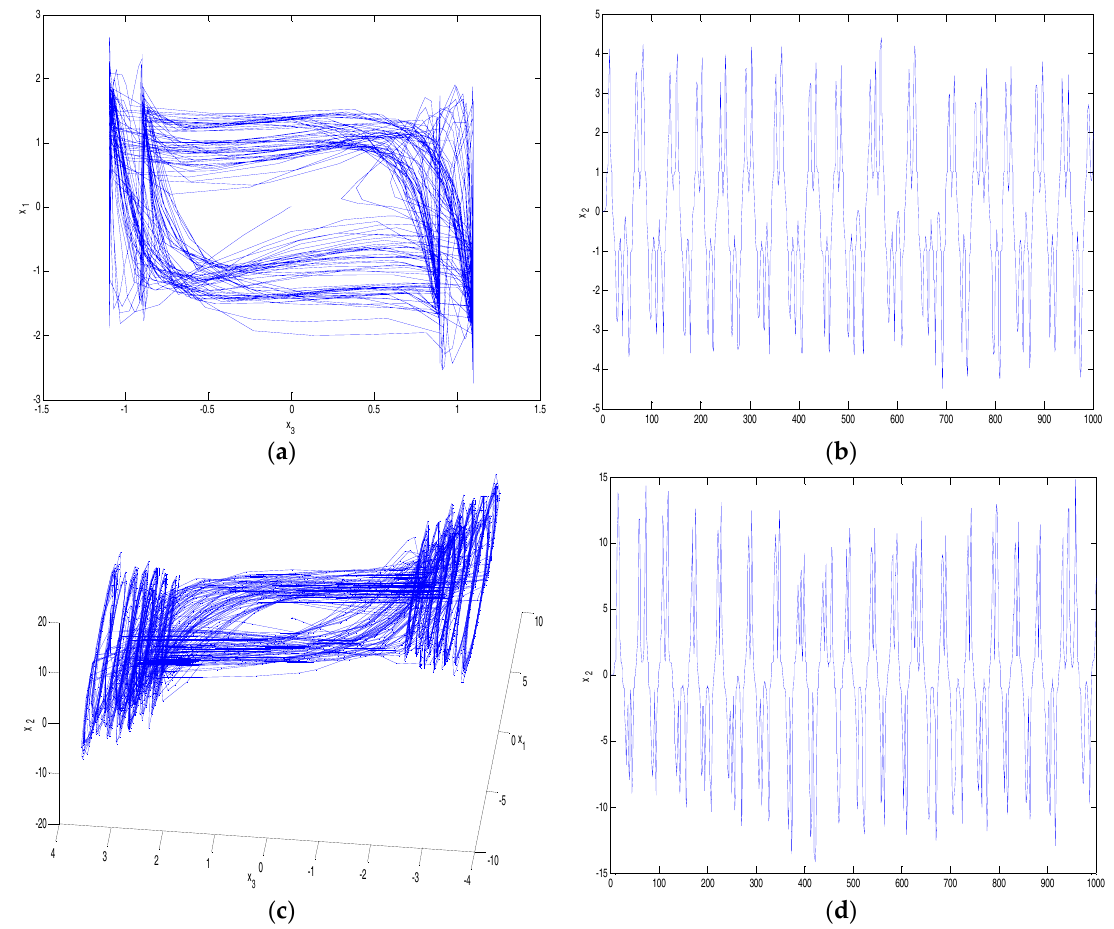
Figure 7. Numerical results of the x 1 ‐ x 3 direction2 ‐ D multi ‐ scroll SC ‐ CNN based system ‐ II: ( a ) 2 ‐ double scrollin x 1 ‐ x 2 ‐ x 3 plane; ( b ) variable x 1 (t); ( c ) 7 ‐ double scrollin x 1 ‐ x 2 ‐ x 3 plane; and ( d ) variable x 2 (t).